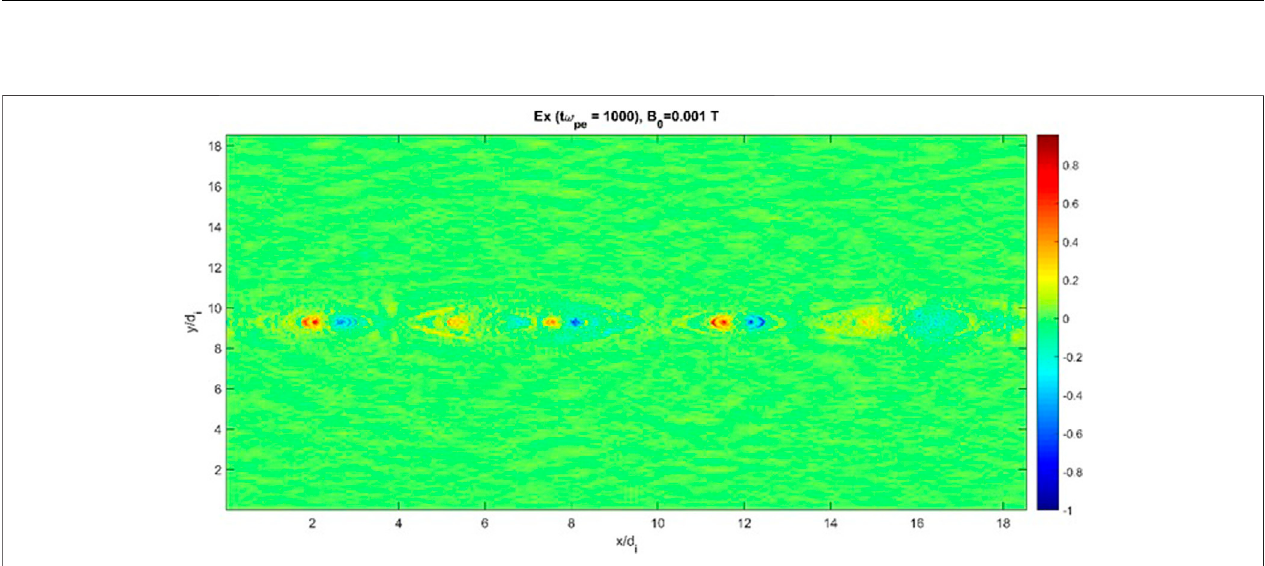
FIGURE 7 | E x plot at time t ω pe (cid:1) 1,000 for B 0 (cid:1) 0.001 T .